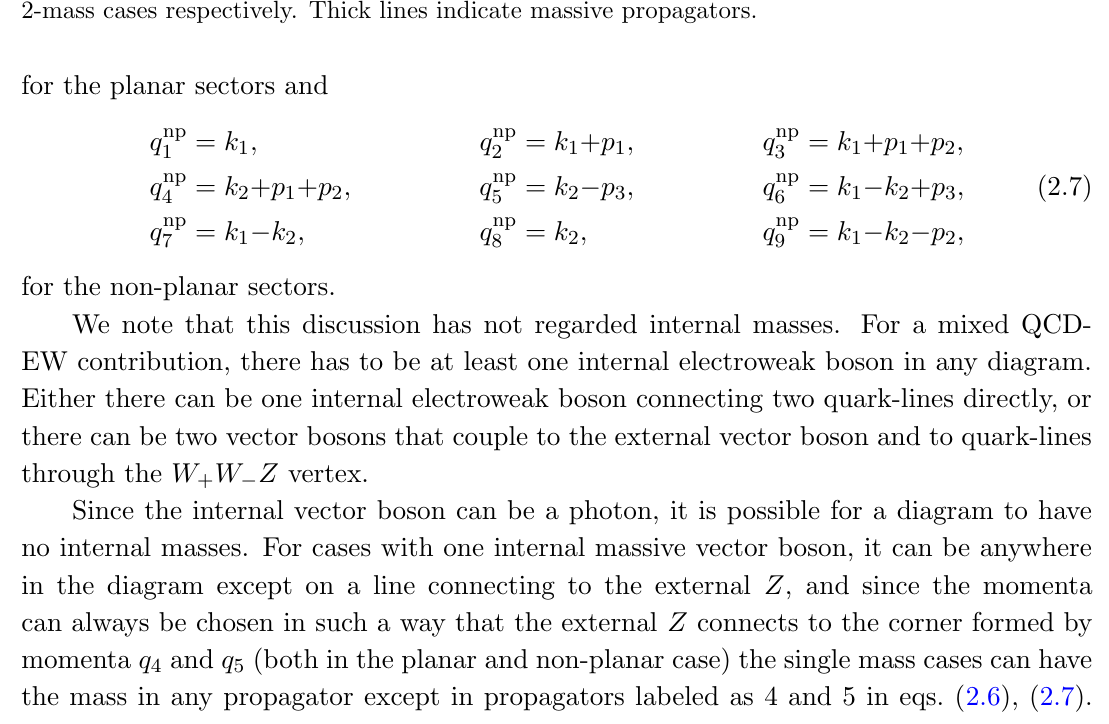
Figure 3 . Representative planar Feynman diagrams, contributing to the 0-mass, 1-mass, and 2-mass cases respectively. Thick lines indicate massive